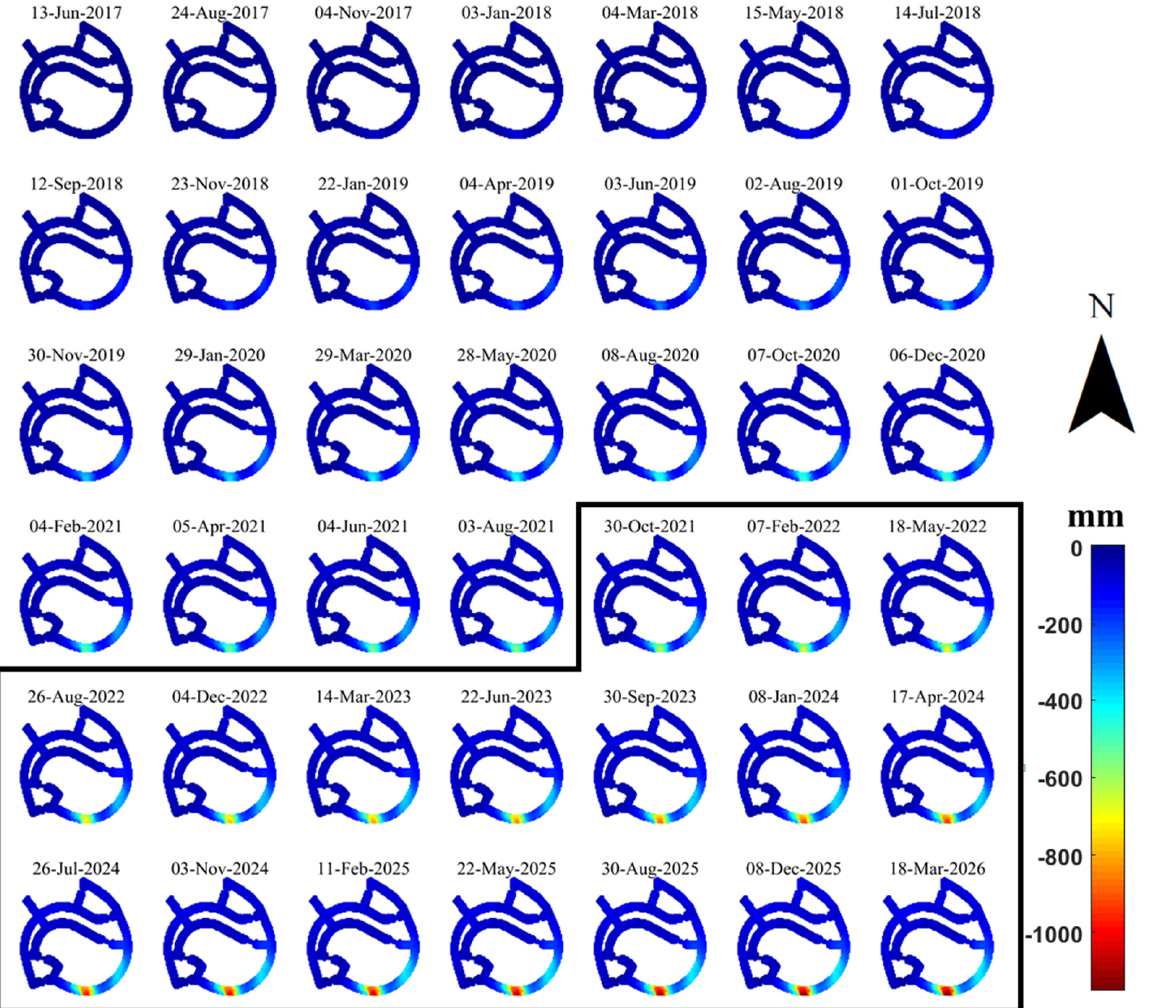
Figure 11. Cumulative vertical deformation time series maps. Cumulative deformation time series in black frame (estimated with respect to the first SAR time acquisition on 13 June 2017) from 2021 to 2026, which is obtained by the prediction model in this study.